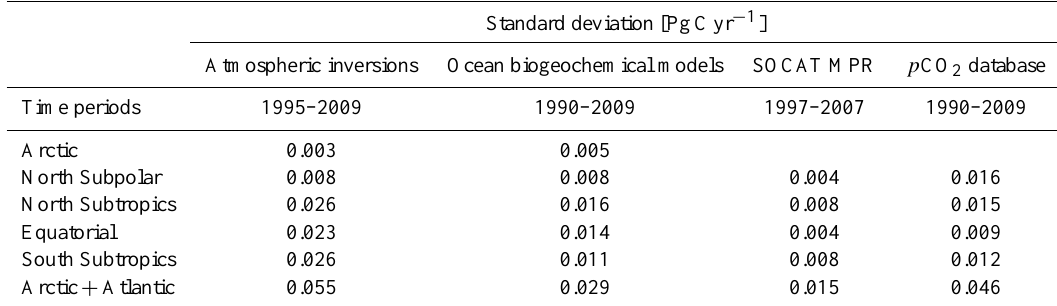
Fig. 6. Low-frequency IAV of spatially integrated sea–air CO 2 fluxes [PgCyr − 1 ] in the (a) Arctic, (b) North Subpolar, (c) North Subtropics, (d) Equatorial, and (e) South Subtropics for atmospheric inversions (black), ocean models (magenta), and p CO 2 database (cyan). Shaded regions are the spread between maximum and minimum from the atmospheric inversion and ocean models, and the uncertainty of the harmonic fit for the p CO 2 database. SOCAT MPR is not included because its timescale is too short. IAV at BATS (red) and ESTOC (dark blue) are included in the North Subtropics. Table 6. Standard deviation of low-frequency IAV for each region and each methodology. Results were deseasonalized and detrended before the calculation of the standard